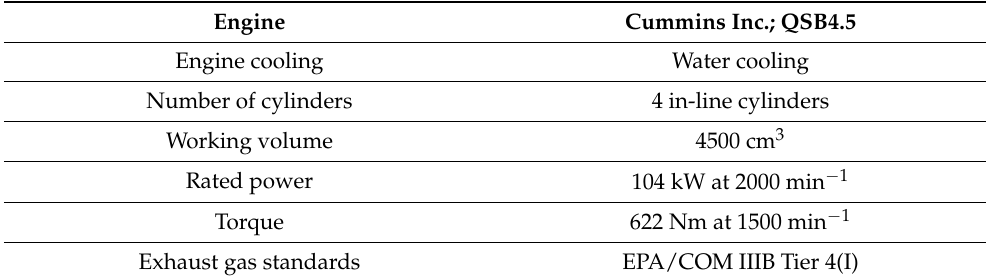
Figure 1. Skidder ECOTRAC 140 V. Table 1. Technical specifications of the ECOTRAC 140 V skidder engine.